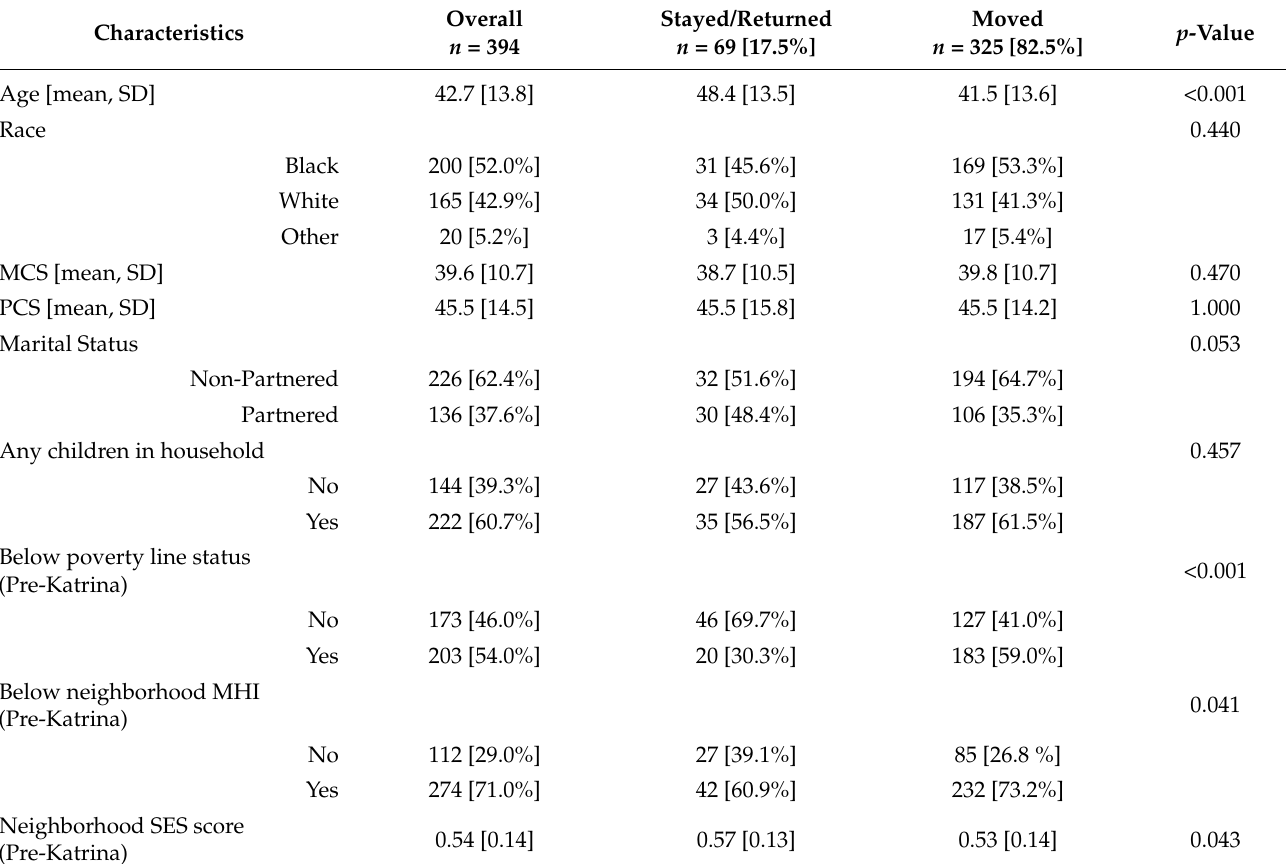
Table 1. Baseline characteristics by move status among GCAFH study